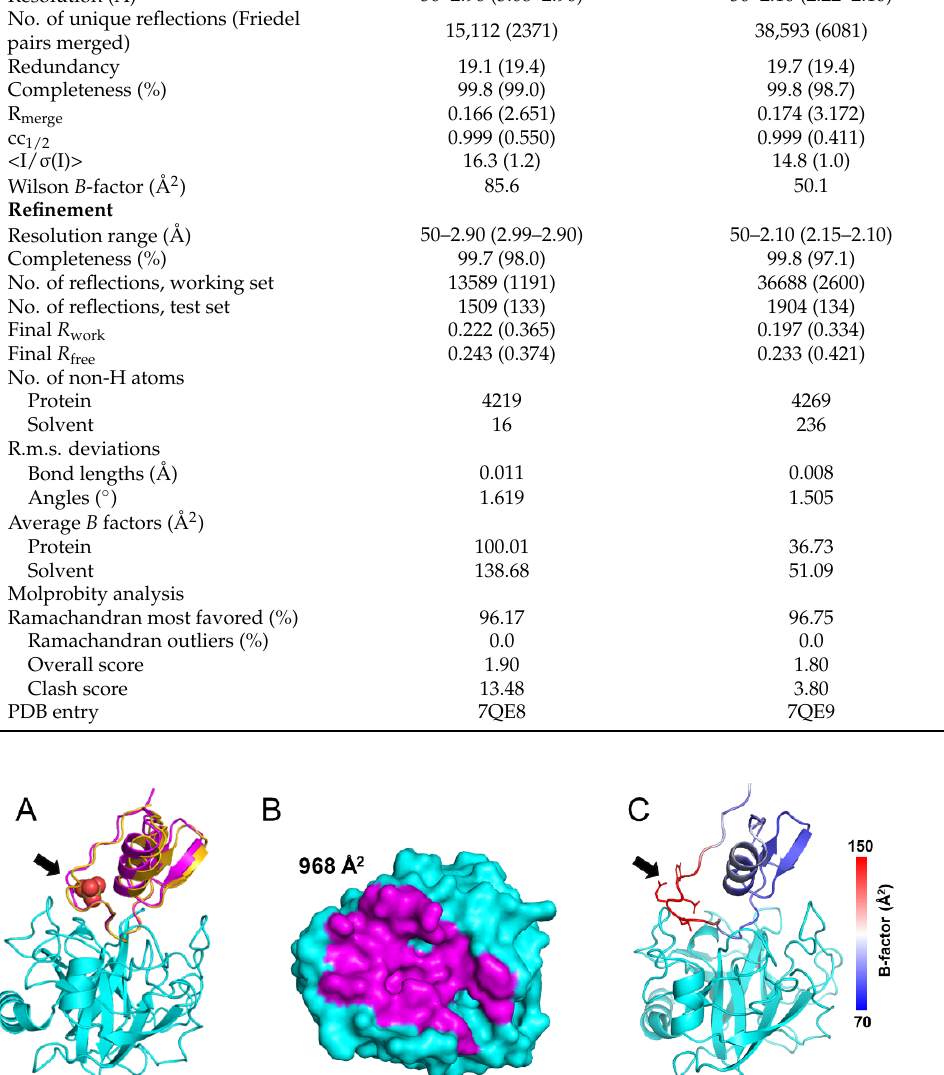
Figure 2. Structure and superposition of TRY1 p.S200A–SPINK1 complexes. The black arrow indicates the position of the p.N34S mutation site. ( A ) Structures and superposition of TRY1 p.S200A (cyan) in complex with SPINK1 WT (yellow) or p.N34S (pink). Sulfate ions are shown as spheres and are colored according to their atom type. ( B ) Binding interface of SPINK1 p.N34S. Due to their similarity, the binding interface of SPINK1 WT was omitted but can be seen in Supplementary Figure S1. ( C ) SPINK1 WT in complex with TRY1 colored by B-factors.